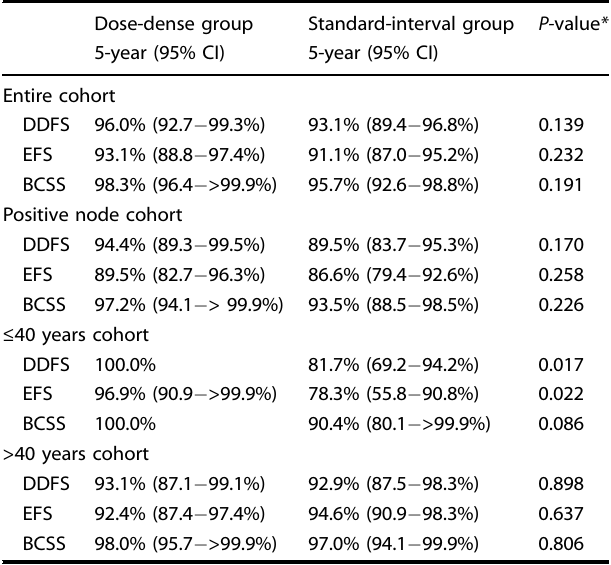
Table 4. Comparisons of survival outcomes between the dose-dense group and the standard-interval group in the entire cohort and in positive nodes cohort, then strati fi ed by age